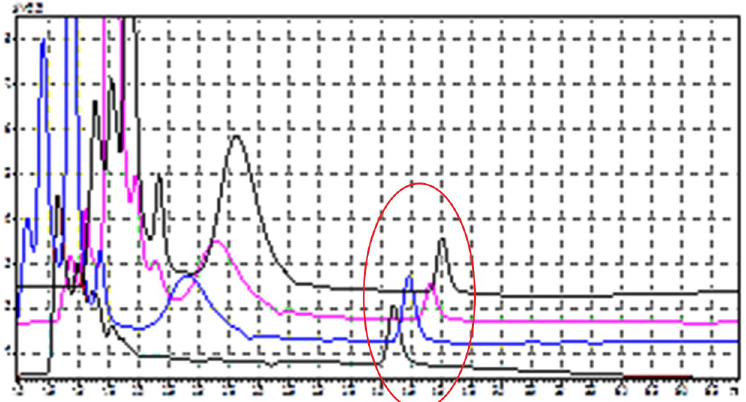
Fig 1. Chromatograms showing mefloquine peaks (located inside red circle at a retention time of 4.3 mins) after 30 mins. Brown trace = negative control i.e. incubation with no NADP cofactors, blue trace = canine microsome incubation, pink trace = possum microsome incubation and black trace = feline microsome incubation.